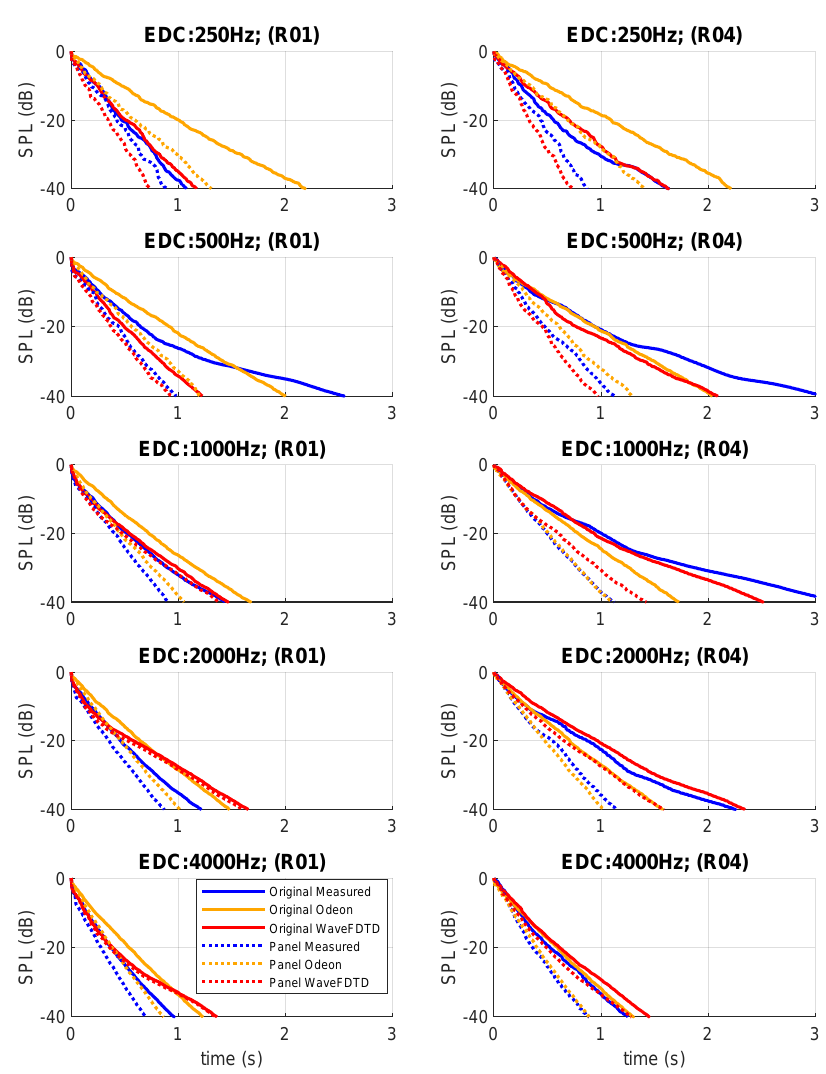
Figure 10. Energy decay curves for receiver location R01 (audience, 3m from source) and R04 (aisle, 3m from source); before and after the addition of the acoustical panels. For conciseness, only the 250Hz through 4000Hz octave bands are